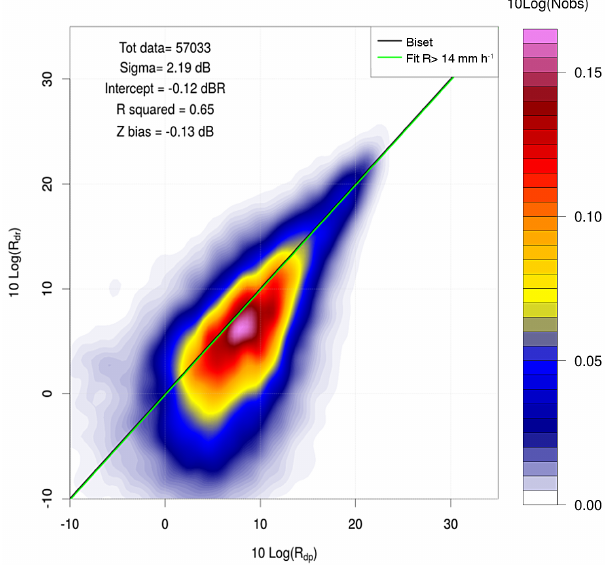
Figure 9. As in Fig. 6 but for the Bric della Croce radar, 13 October 2014.